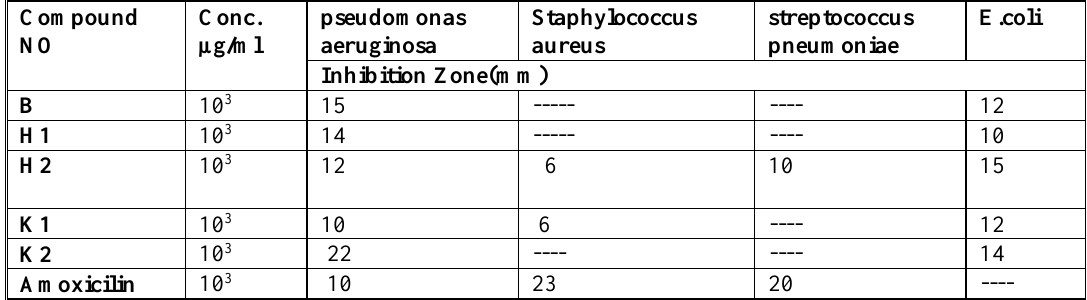
Table 2. The antibacterial activity of the target compounds(B,H1-H2,K1,K2). Compound Conc. pseudomonas Staphylococcus streptococcus E.coli NO µg/ml aeruginosa aureus pneumoniae Inhibition Zone(mm) B 10 3 15 ----- ---- 12 H1 10 3 14 ----- ---- H2 K1 K2 10 3 22 ---- ---- 14 Amoxicilin 10 3 10 23 20